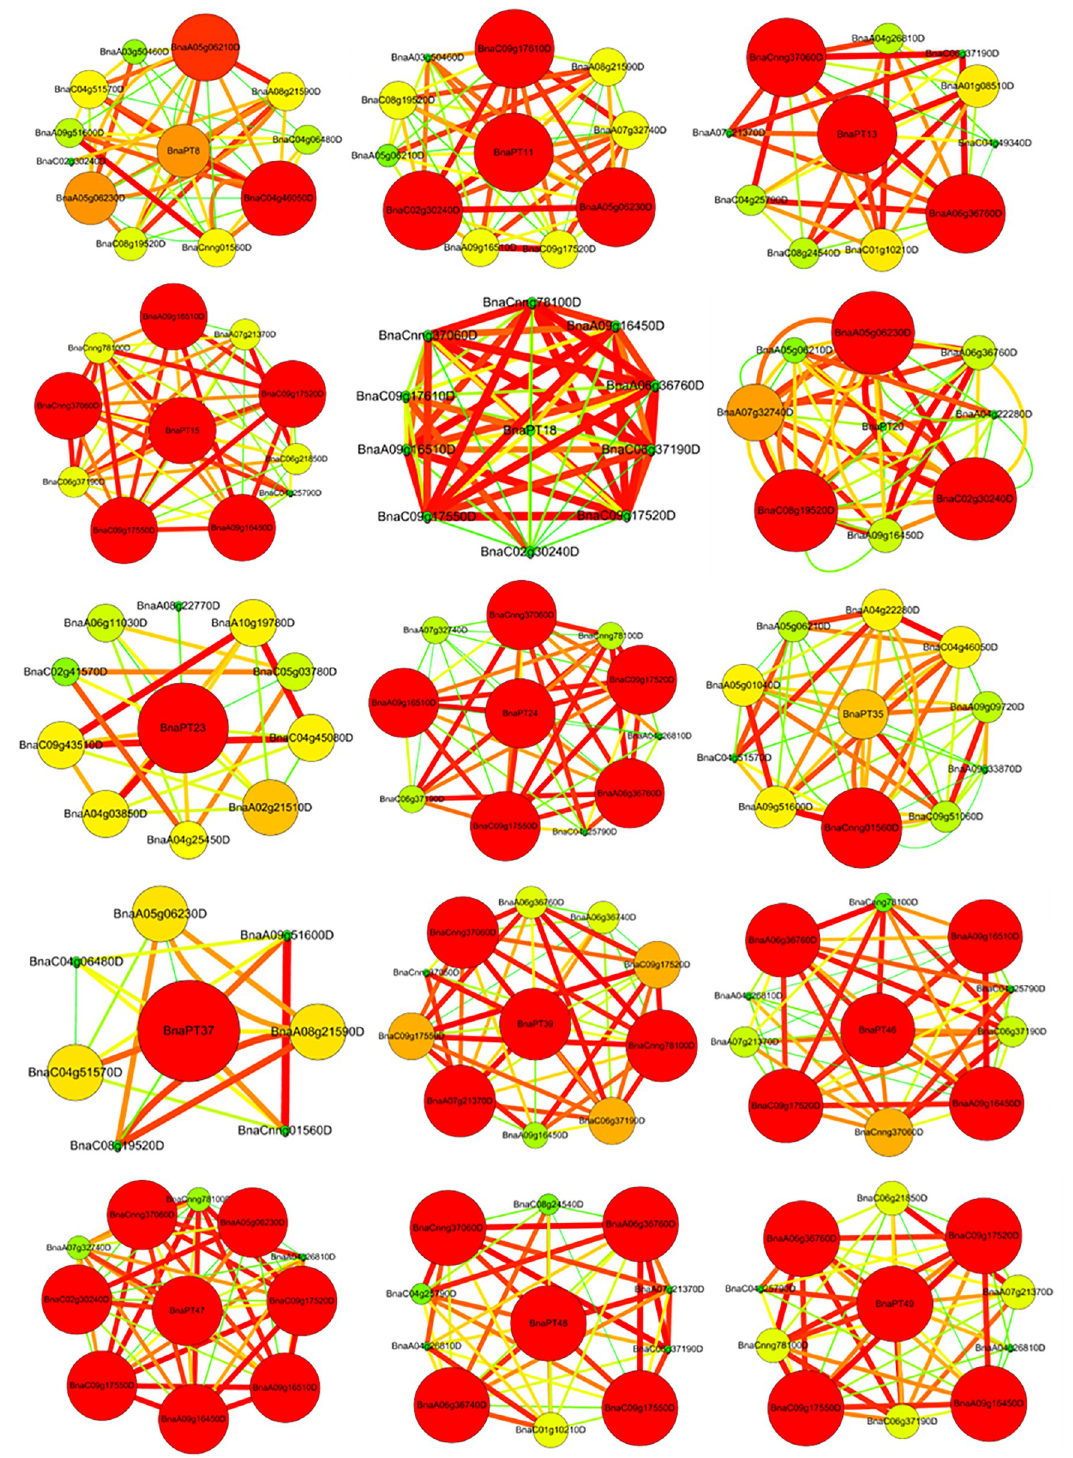
Fig 7. Coexpression networks of 15 PHT1 family genes in Brassica napus . Cycle nodes represent genes, and the size of the nodes represents the power of the interrelation among the nodes by degree value. The width of the lines between two nodes represent interactions between genes. The PHT1 family genes located in the center of the network, while the 10 most coexpressed genes were displayed in each network.